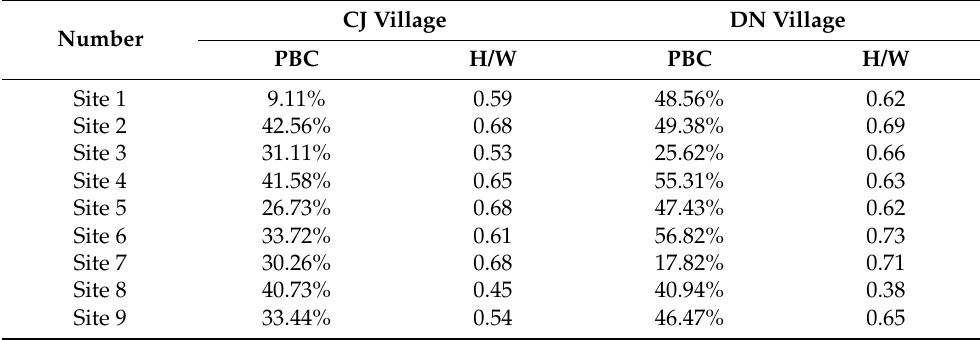
Table 4. Percentage of building coverage (PBC) within a 150 m circle and the ratio between height and width (H/W) in two